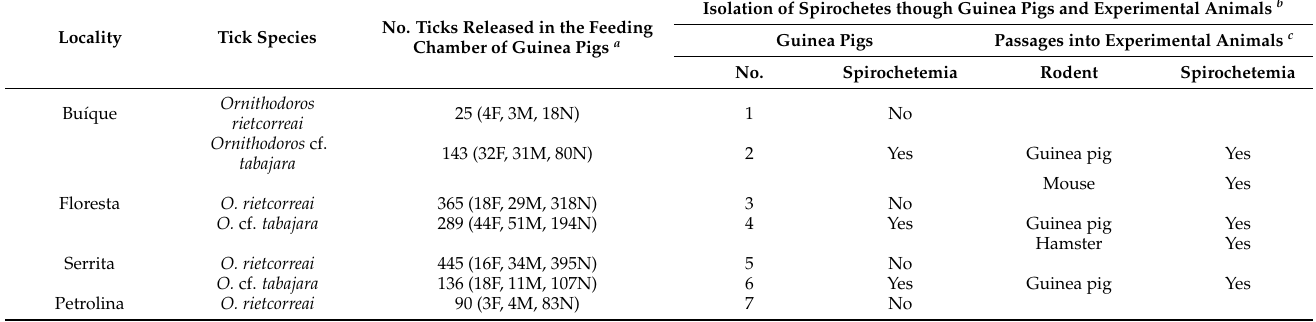
Table 2. Results of infestation trials for isolation of spirochetes from Ornithodoros ticks that were collected in four localities of the state of Pernambuco, Caatinga biome, Brazil, during 2019.